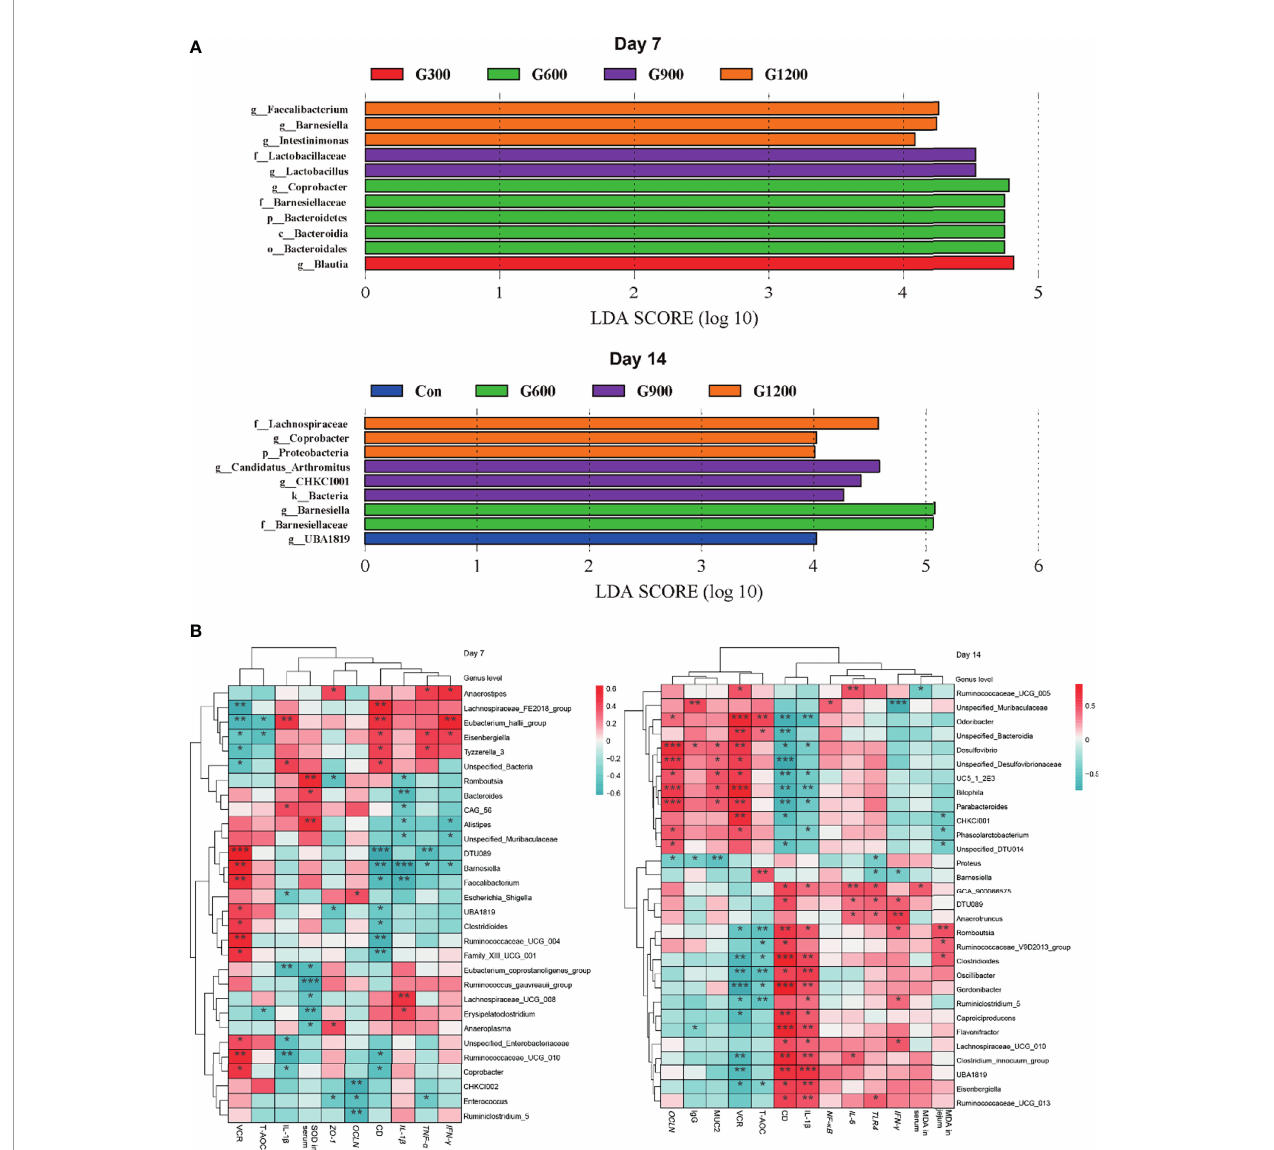
FIGURE 4 | (A) LEfSe analysis of cecal microbiota (LDA score is greater than 4). (B) Heatmap of correlation among cecal microbiota, in fl ammatory factors, tight junctions, antioxidant enzymes, and intestinal integrity by Spearman analysis. * P < 0.05, ** P < 0.01, *** P < 0.001. Con, basal diet; G300, 600, 900, and 1200, basal diets complemented with 300, 600, 900, or 1200 mg/kg